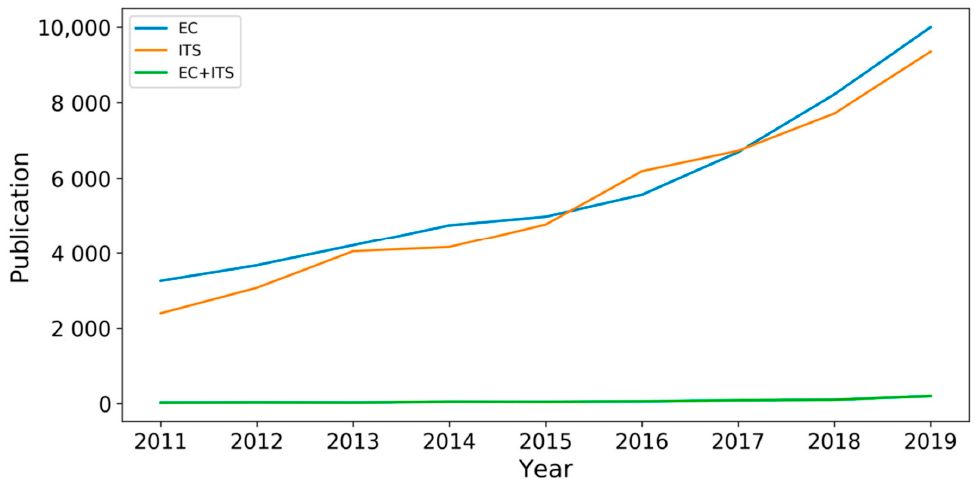
Figure 1. The number of publications from 2011 to 2019 on the topics of (1) edge computing, (2) intelligent transportation systems, and (3) edge computing + transportation. The statistics are from the Web of Science.